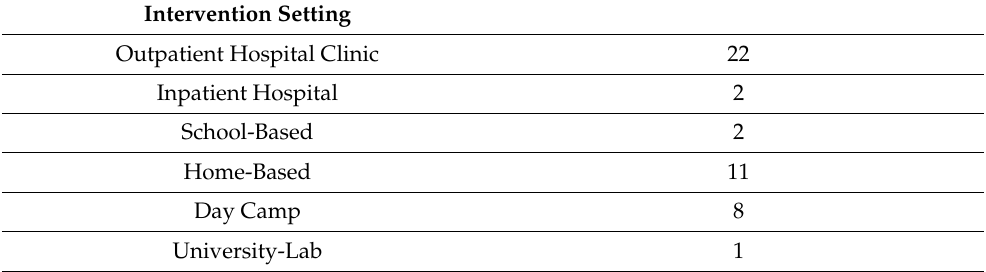
Table 4. Intervention Setting.